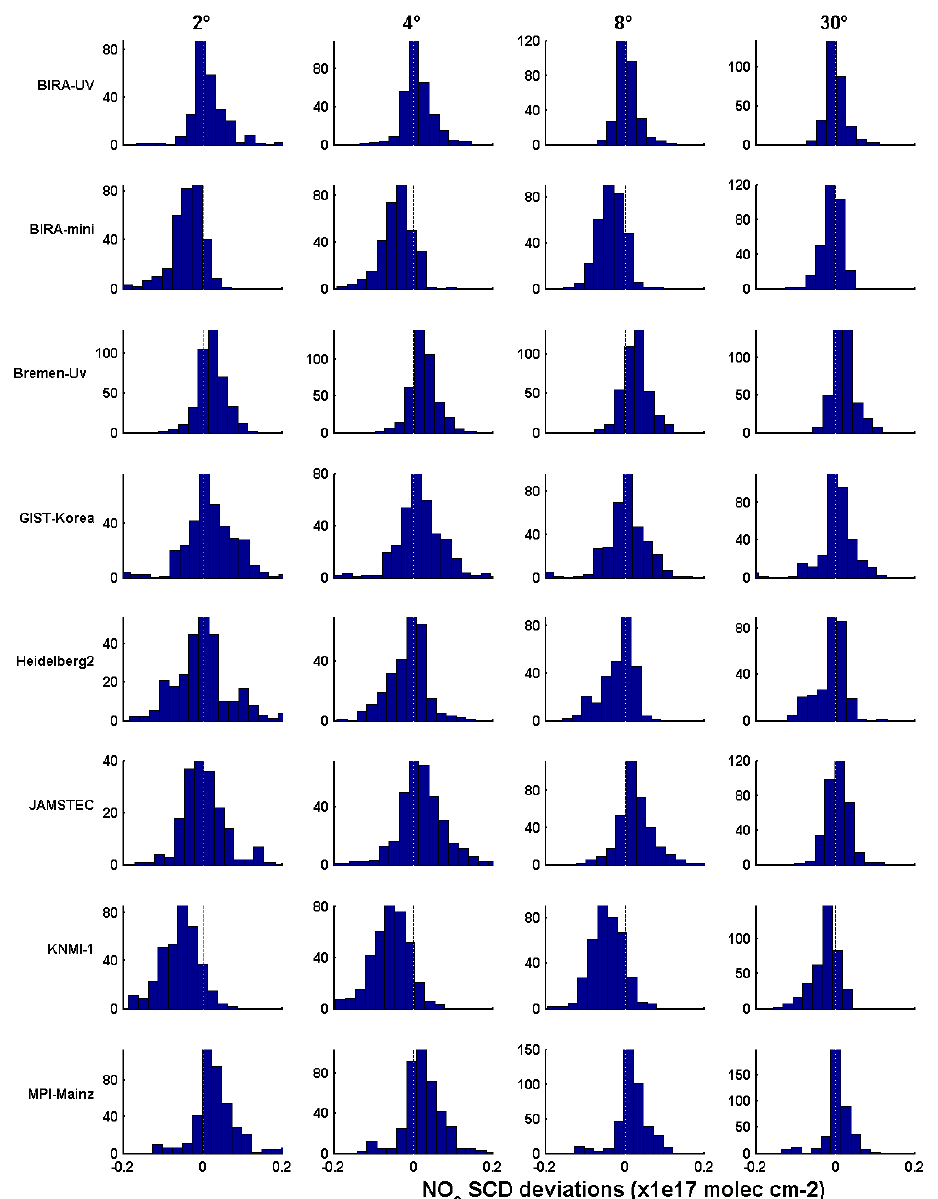
Fig. 12. Histograms of the absolute deviations of UV measurements from the reference UV data set, for the whole campaign.